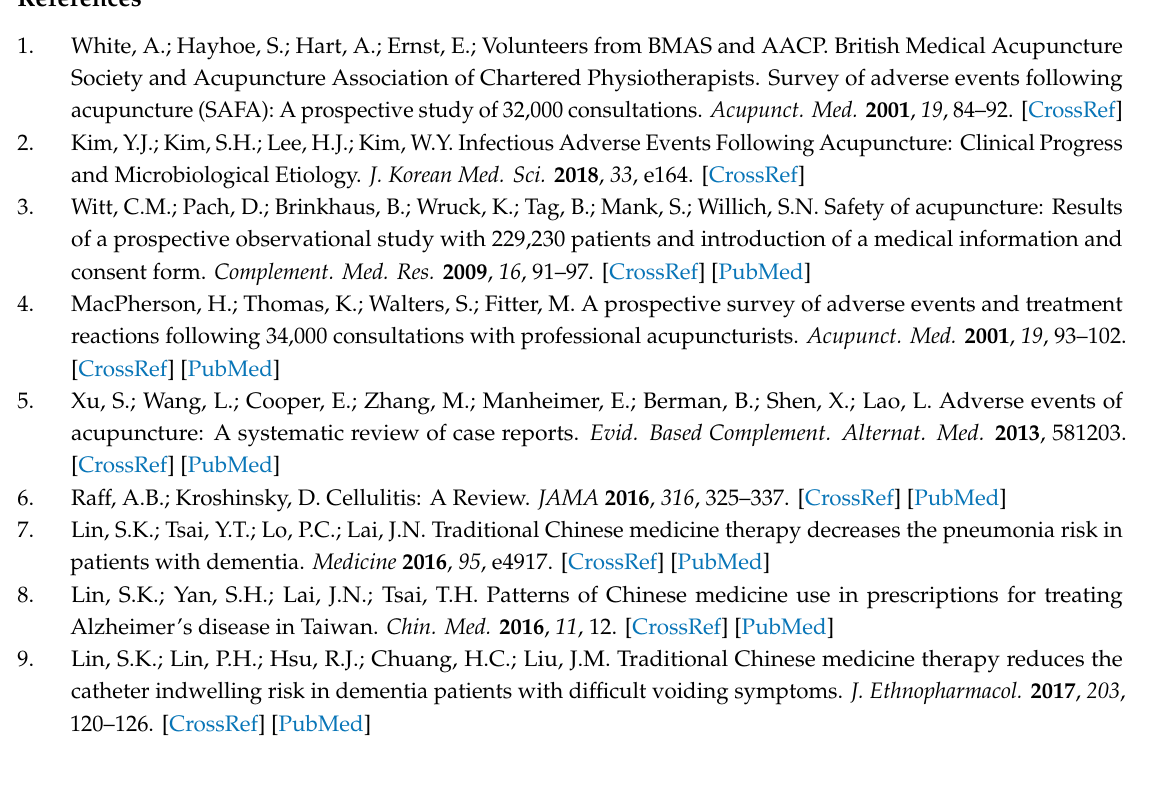
Table S1: ICD-9 diagnostic codes of 33 autoimmune